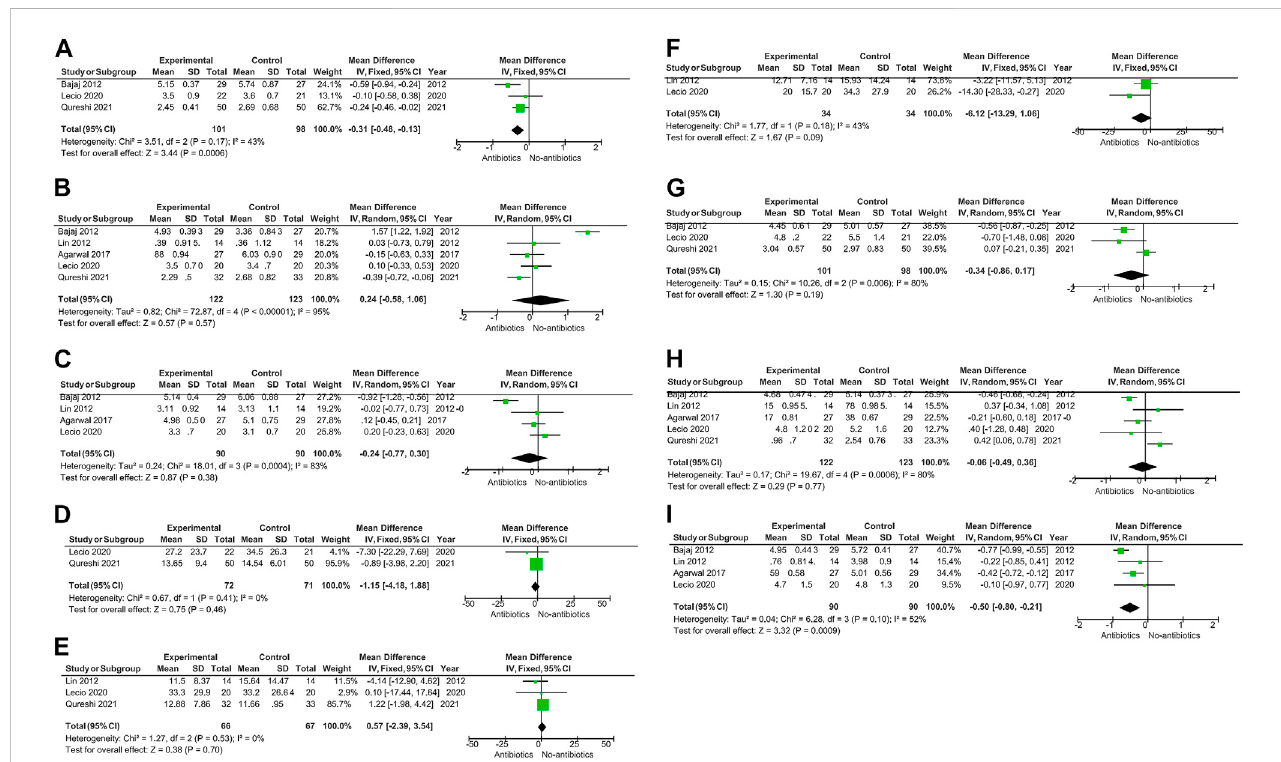
FIGURE 4 When topical antibiotics were used, there was a signi fi cant improvement in PD at 1 month ( p = 0.0006) and CAL at 6 months ( p = 0.0009). However, there were no statistically signi fi cant differences in the other